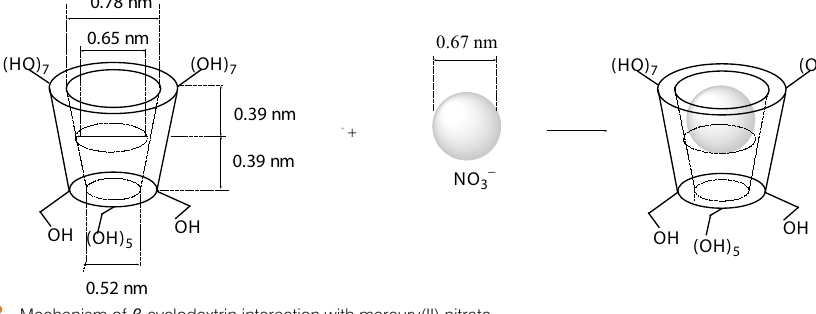
Scheme 2. Mechanism of β -cyclodextrin interaction with mercury(II)